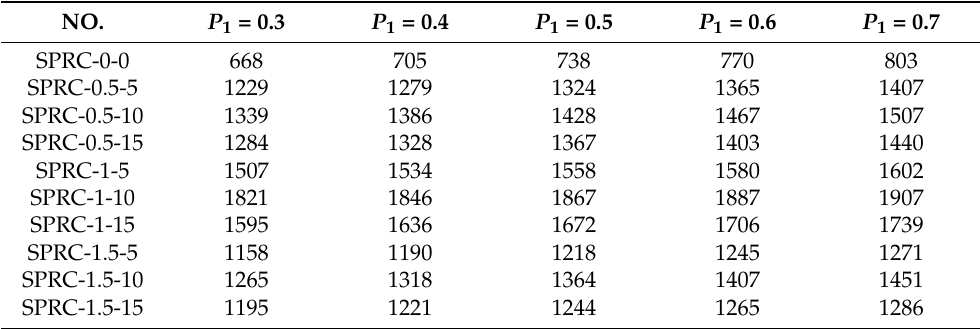
Table 6. Impact life of each group of specimens under different failure probabilities (times).